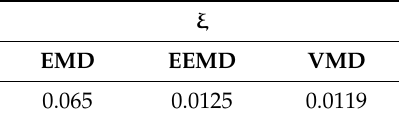
Table 1. Evaluation index of energy leakage.